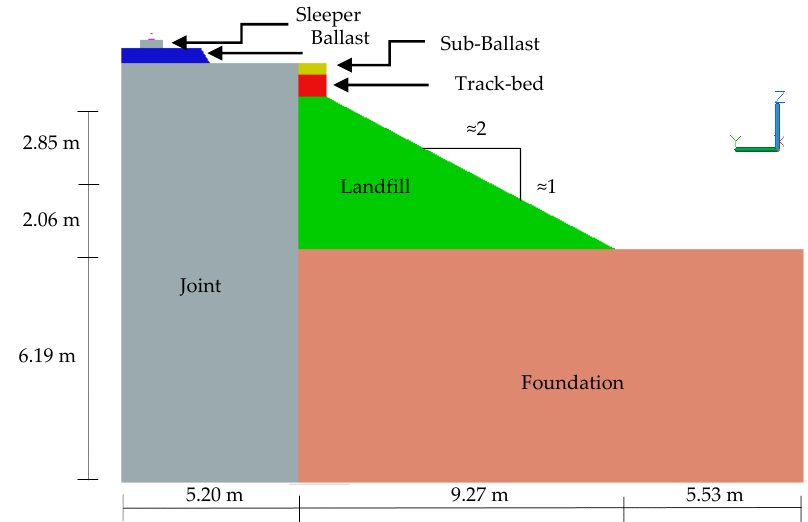
Figure 3. Transverse geometric arrangement and components with dimensions defined in the YZ plane viewed facing the joint.